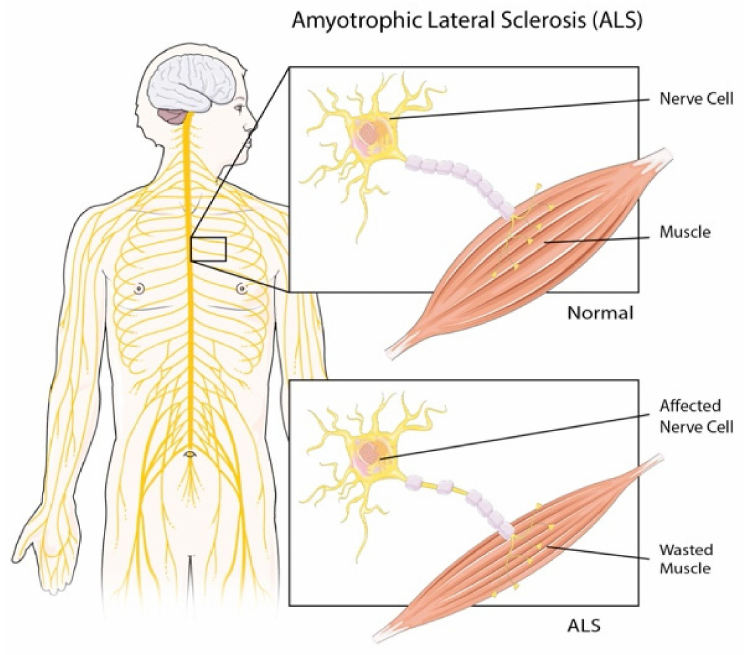
Figure 1. Amyotrophic lateral sclerosis. The motor neurons degeneration in ALS causes muscular atrophy